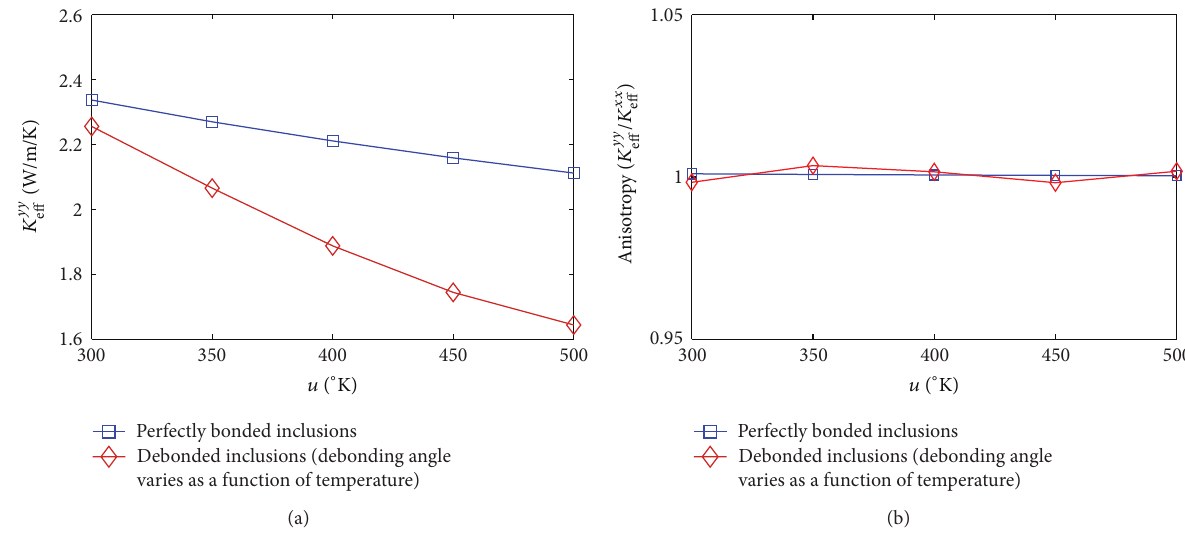
Figure 8: Effective thermal conductivity of the randomly heterogeneous media as a function of temperature: (a) result estimated in the 𝑦𝑦 ; (b) anisotropy of the effective thermal conductivity 𝐾 vertical direction 𝐾 eff